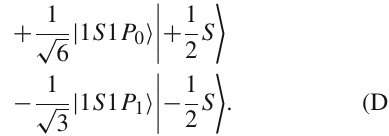
Table 2 Summary of states for systems ccc and bbb . For example, (cid:7) 1 D 1 S − ⊗